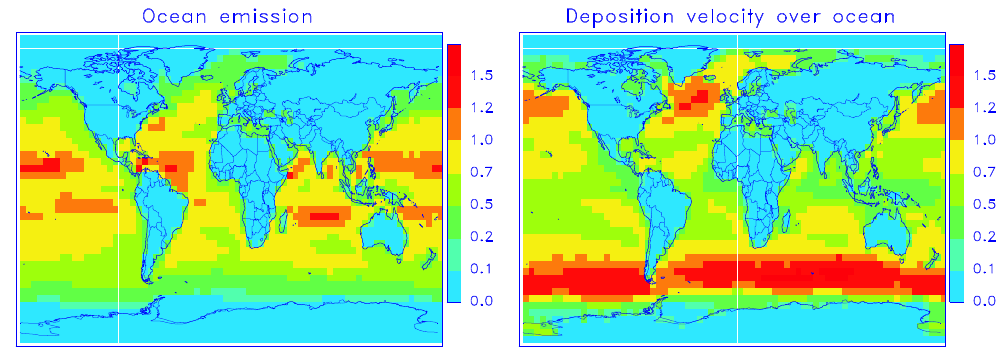
Fig. 2. Annually averaged methanol ocean emission fluxes (left, in 10 10 molec.cm − 2 s − 1 ), and deposition velocity over ocean (right), expressed